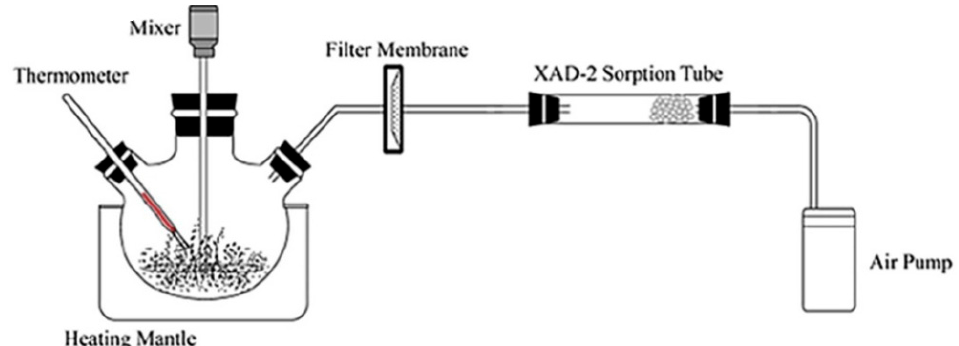
Figure 1. Diagram of mixing apparatus and filter system [18]. Reprinted from Journal of Hazardous Materials , vol 371, Shicong Mo, Yuhong Wang, Feng Xiong, Chunjin Ai, Effects of asphalt source and mixing temperature on the generated asphalt fumes, pg. 342–351, Copyright (2019), with permission from Elsevier.